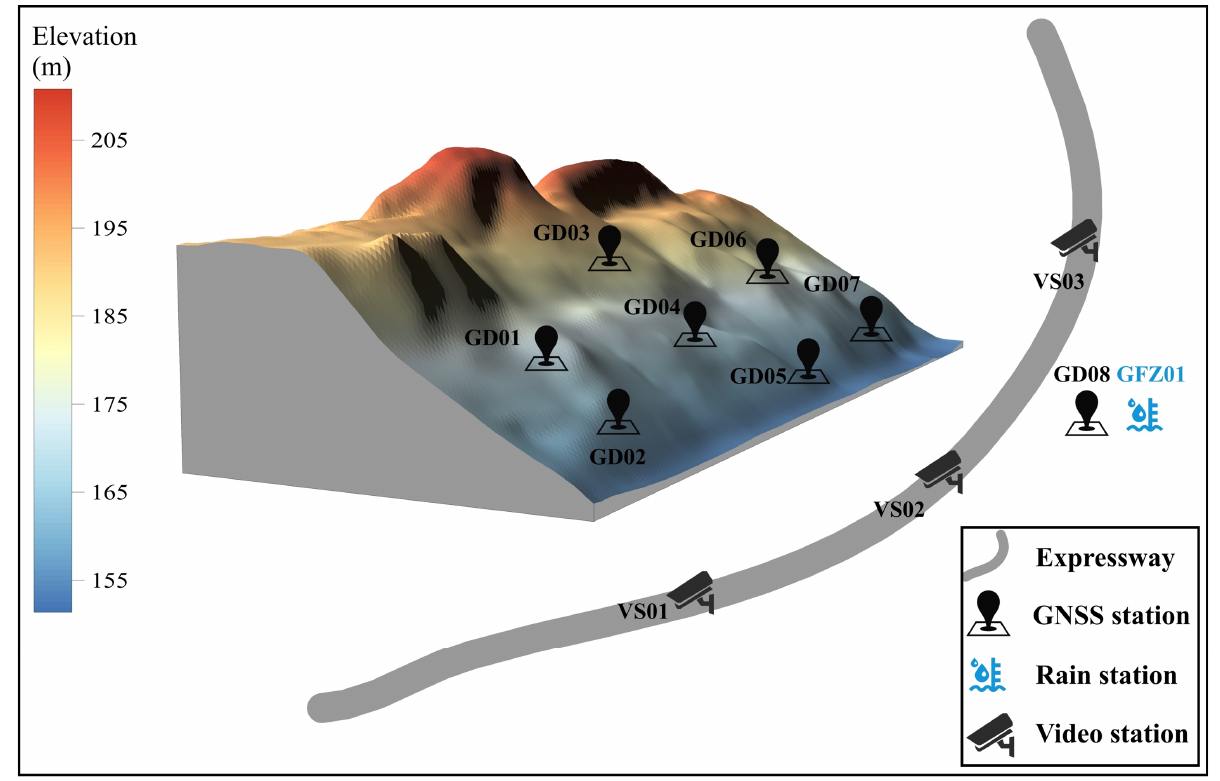
Figure 3. On-site findings in November 2018: ( a ) cracking of retaining wall, ( b ) guttering deformation, and ( c ) collapse.